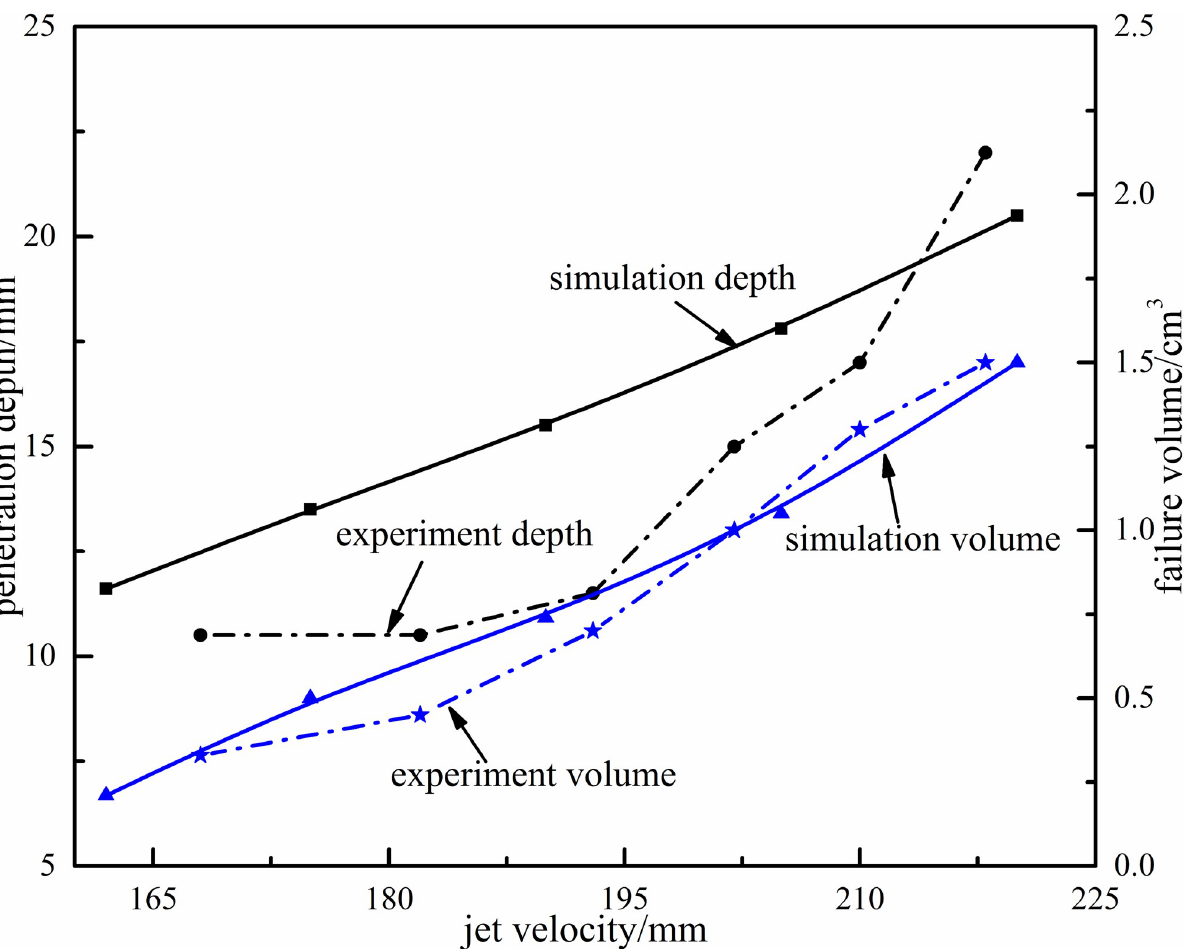
Fig 15. The effect of jet velocity on failure volume and penetration